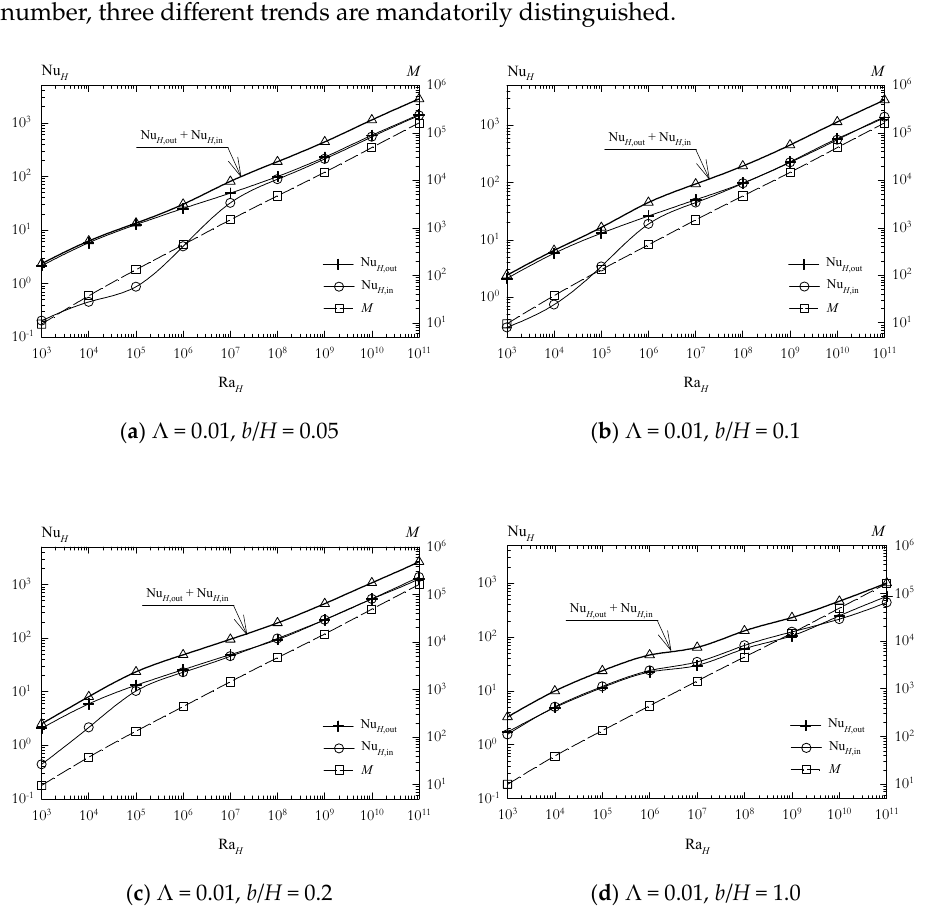
Figure 3. Evolution of average Nusselt number Nu H and dimensionless mass-flow-rate M as a function of Rayleigh number Ra H , for different values of aspect radio b / H . Configuration is given in Figure 1b. Heating parameter Λ = 0.01.